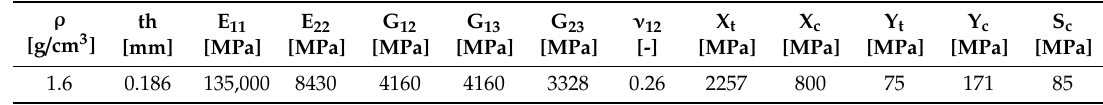
Table 1. Mechanical properties of the